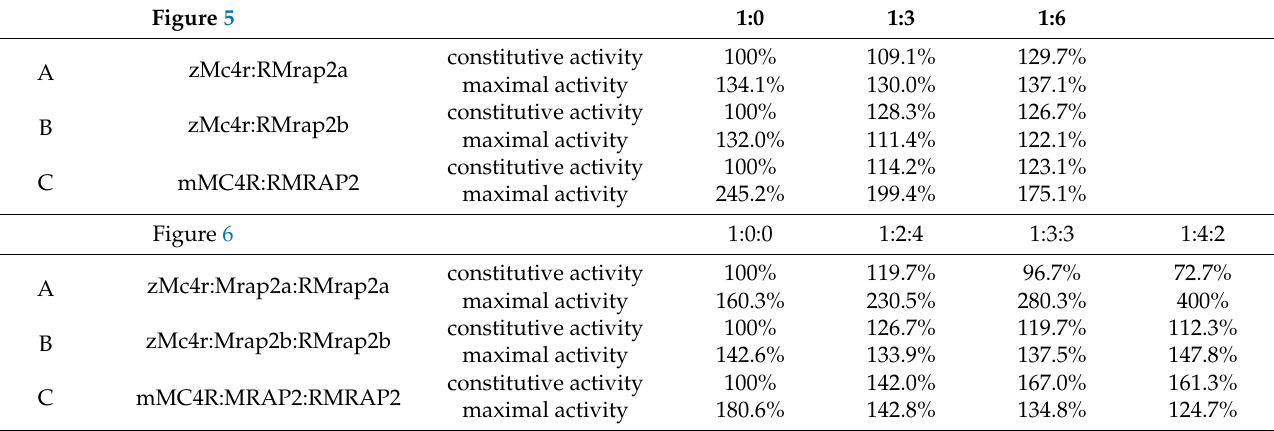
Data shown in Table 1 represent the EC50 of dose–response curves in Figures 5 and 6. Numbers in brackets are with the 95% confidence intervals of nonlinear fittings. One-way ANOVA and Tukey post-tests were employed to measure the significance between the MC4R expression alone group (1:0) and the experimental groups. ns (not significant difference), * p < 0.05, ** p < 0.01, *** p < 0.001. Table 2. Summary of the constitutive and maximal activities of MC4Rs in Figures 5 and